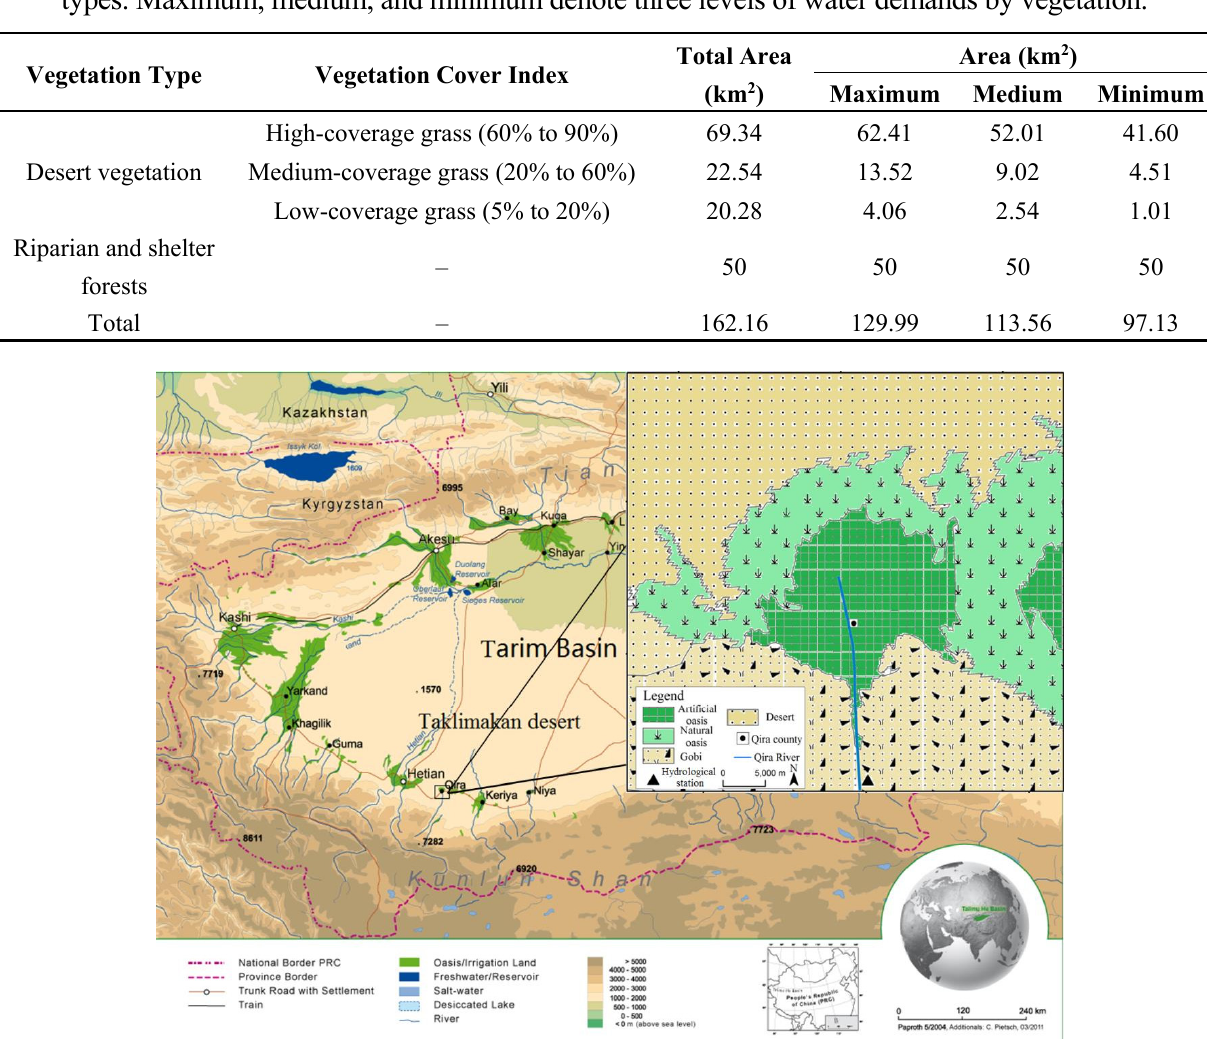
Table 2. Vegetation types, vegetation cover indices, and areas occupied by different vegetation types. Maximum, medium, and minimum denote three levels of water demands by vegetation.